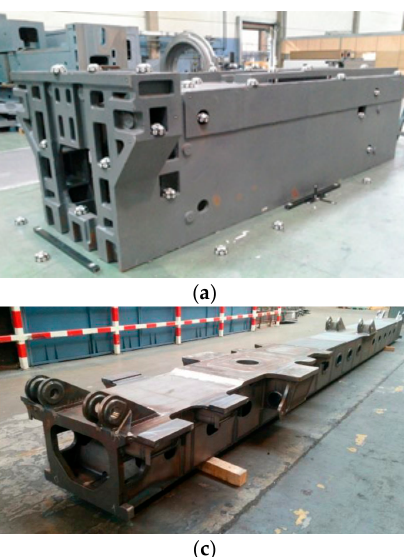
manufactured at Goimek machining shop, and ( c ) Liebherr drilling rig lead center (15 m long), along along with corresponding CAD views ( b , d ) showing measured surfaces (in red) for overstock control.